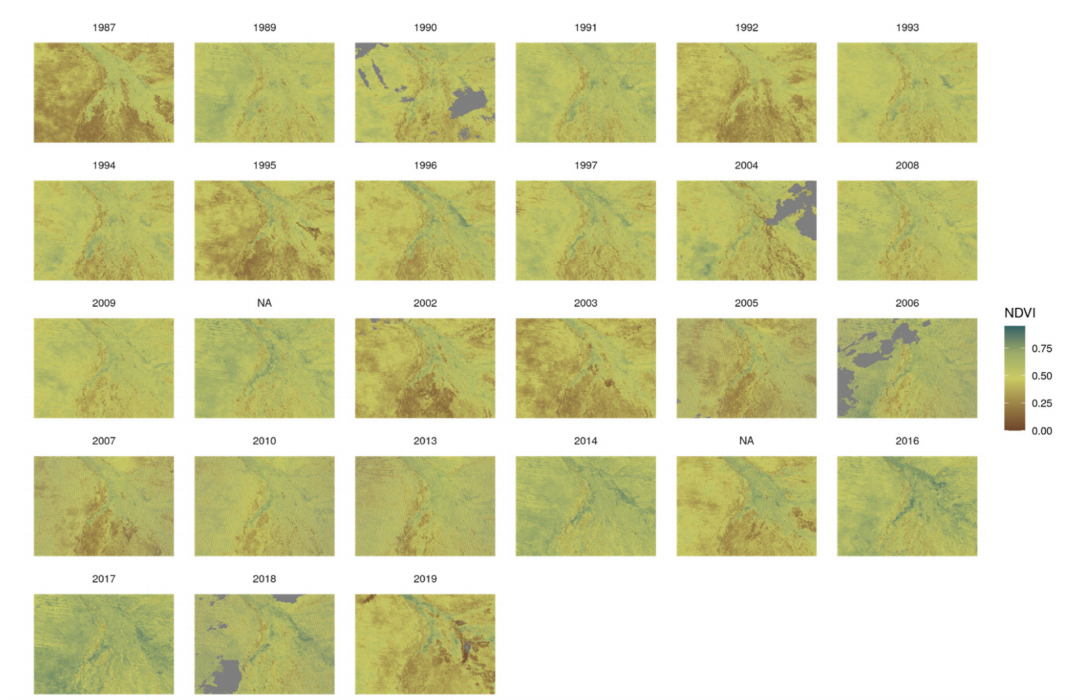
Figure A3. NDVI for 1987–2018 Landsat 5, 7, and 8 fused time series from GEE for all available cloud-free March scenes over the Okavango Delta. The southern extent of the scene has typically low NDVI < 0.25, while the delta has seasonal high NDVI > 0.50. The years 1988, 1998–2000, 2011, and 2012 had no clear sky scenes. The color palette uses the NDVI ramp in R rasterVis. Pixels with no data due to masking are gray.